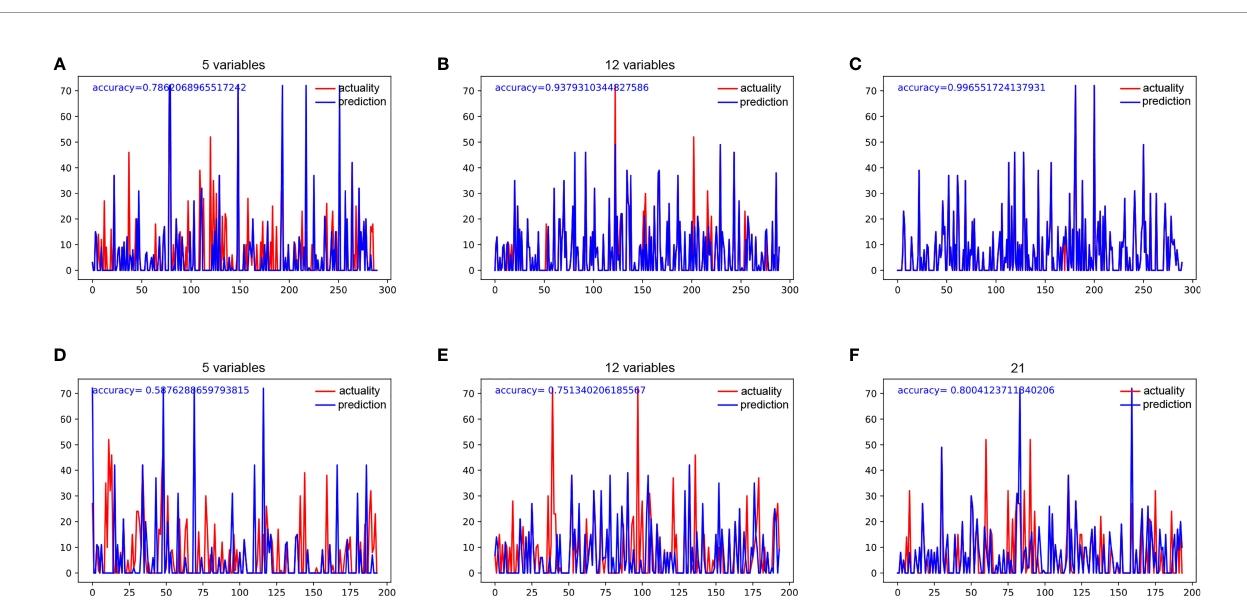
FIGURE 2 | (A) The accuracy of decision tree analysis based on 5 variables in the training group. (B) The accuracy of decision tree analysis based on 12 variables in the training group. (C) The accuracy of decision tree analysis based on 21 variables in the training group. (D) The accuracy of decision tree analysis based on 5 variables in the testing group. (E) The accuracy of decision tree analysis based on 12 variables in the testing group. (F) The accuracy of decision tree analysis based on 21 variables in the testing group.